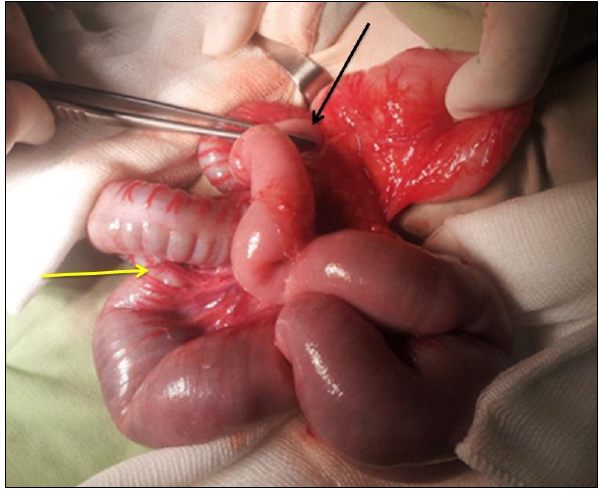
Figure 1: Operative photography shows the length of the small intestine measured from the pylorus less than 30 cm: black arrow shows the pylorus; the yellow arrow shows the ileocecal